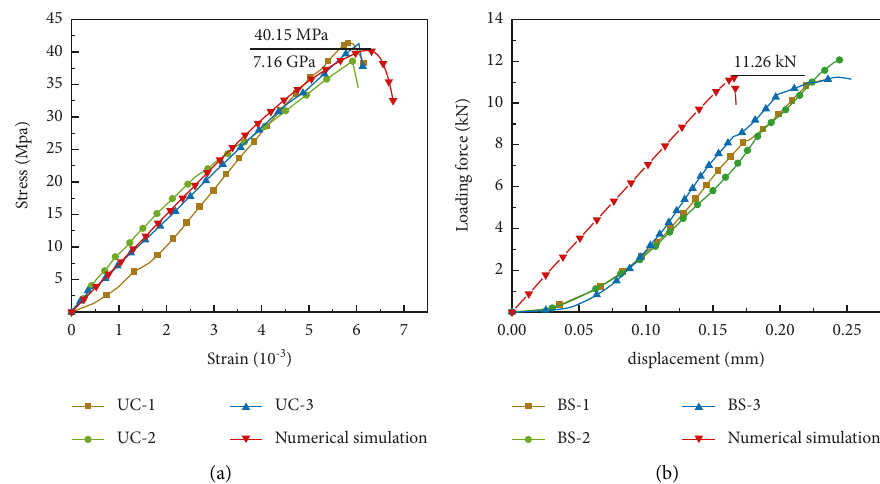
Figure 6: Comparisons between numerical simulations and experiments: (a) axial stress-strain curves of uniaxial compression tests and (b) force-displacement curve of splitting test.